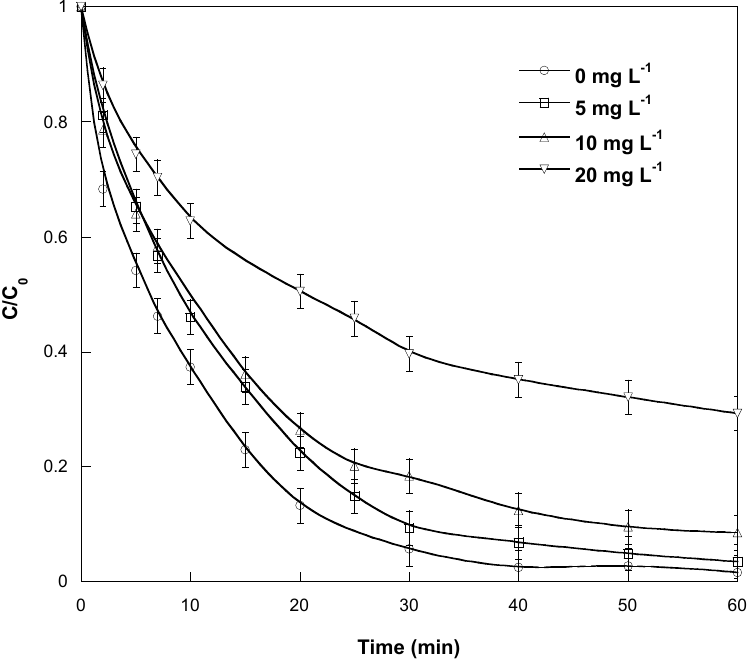
Figure 10. Effect of humic acid on SO removal by UV/TiO 2 /IO 3 − process ([IO 3 − ] = 0.15 mM, [TiO 2 ] = 0.4 g · L − 1 , [SO] = 10 mg · L − 1 and pH~6).